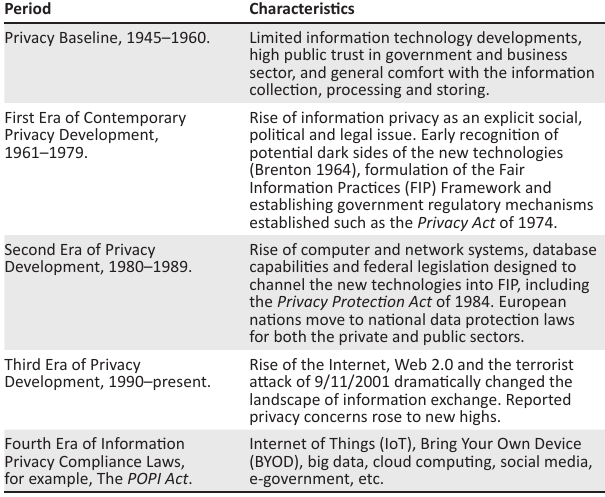
TABLE 1: Evolution of the Information Privacy Concept following the evolution of information technology. Period